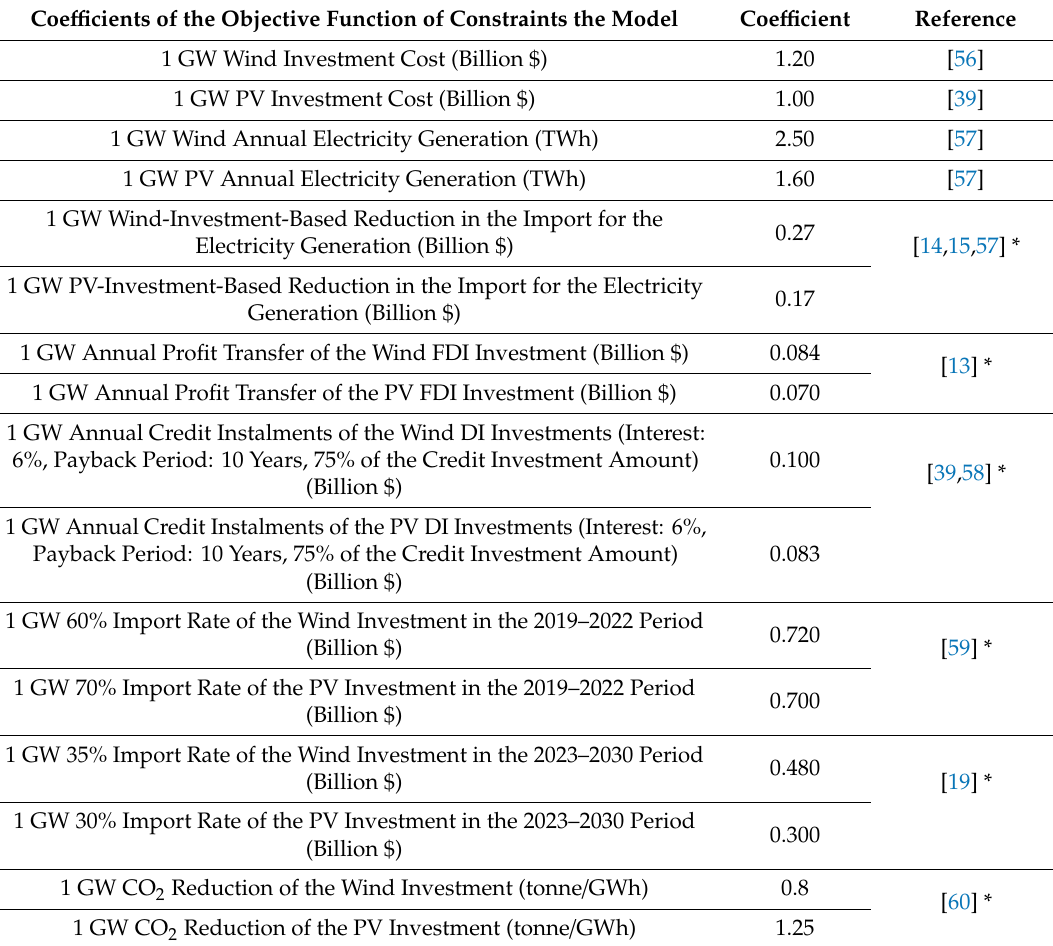
Table 1. Coe ffi cients About the Objective Function and